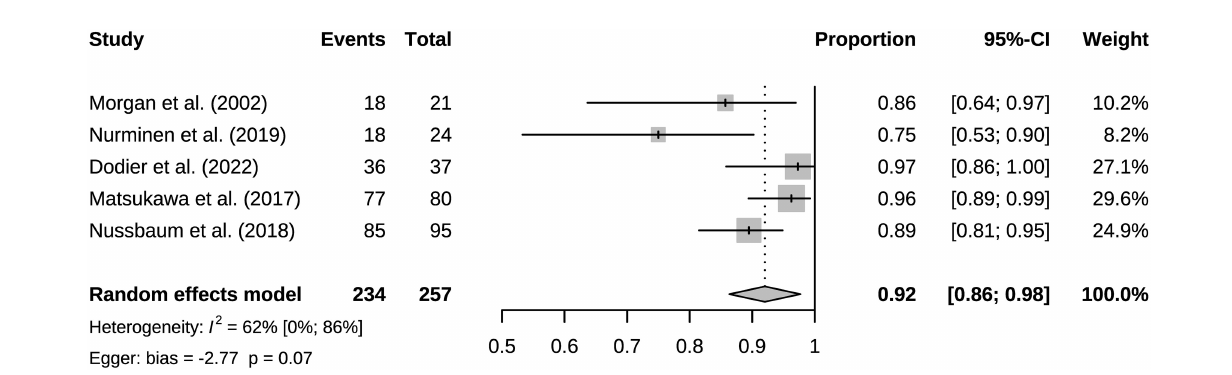
FIGURE8 Long-term follow-up proportion of patients with 0–2 points on the modified Rankin